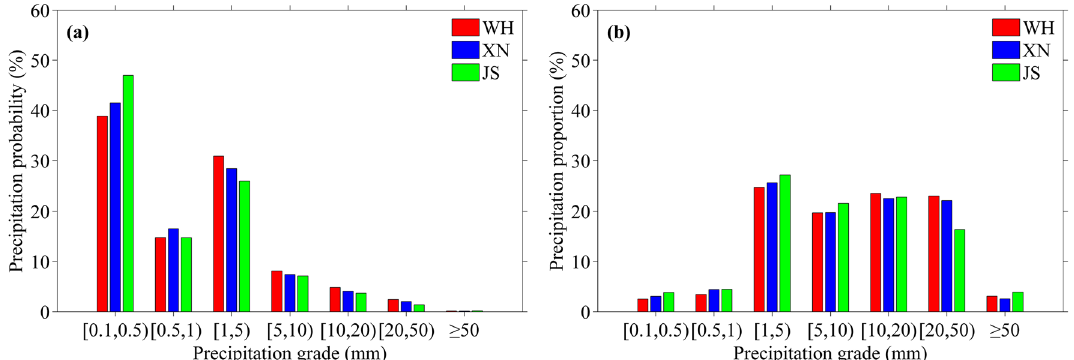
Figure 4. Precipitation ( a ) probability and ( b ) proportion in different grades obtained from summer hourly precipitation data of WH, XN and JS stations during 2007–2019.